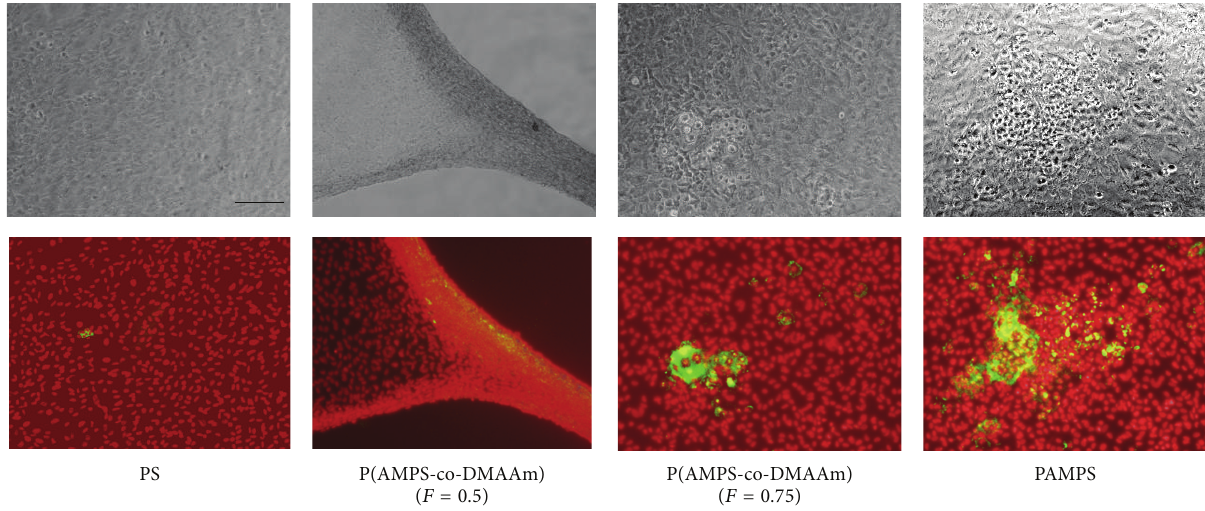
Figure 4: Expression of chondrogenic markers in ATDC5 cells cultured on hydrogels with various charge density; Polystyrene dish (PS), PDMAAm gel, P(AMPS-co-DMAAm) (molar fraction of AMPS, 𝐹 = 0.5 , 0.75), and PAMPS gel, in the absence of insulin. Scale bar, 100 𝜇 m. Expression of type II collagen was analyzed by immunofluorescent staining at 14 days of culture. The cells were stained with an antitype II collagen antibody (green) and Hoechst 33258 (red). Reproduced with permission from [22]. © 2010, Elsevier,